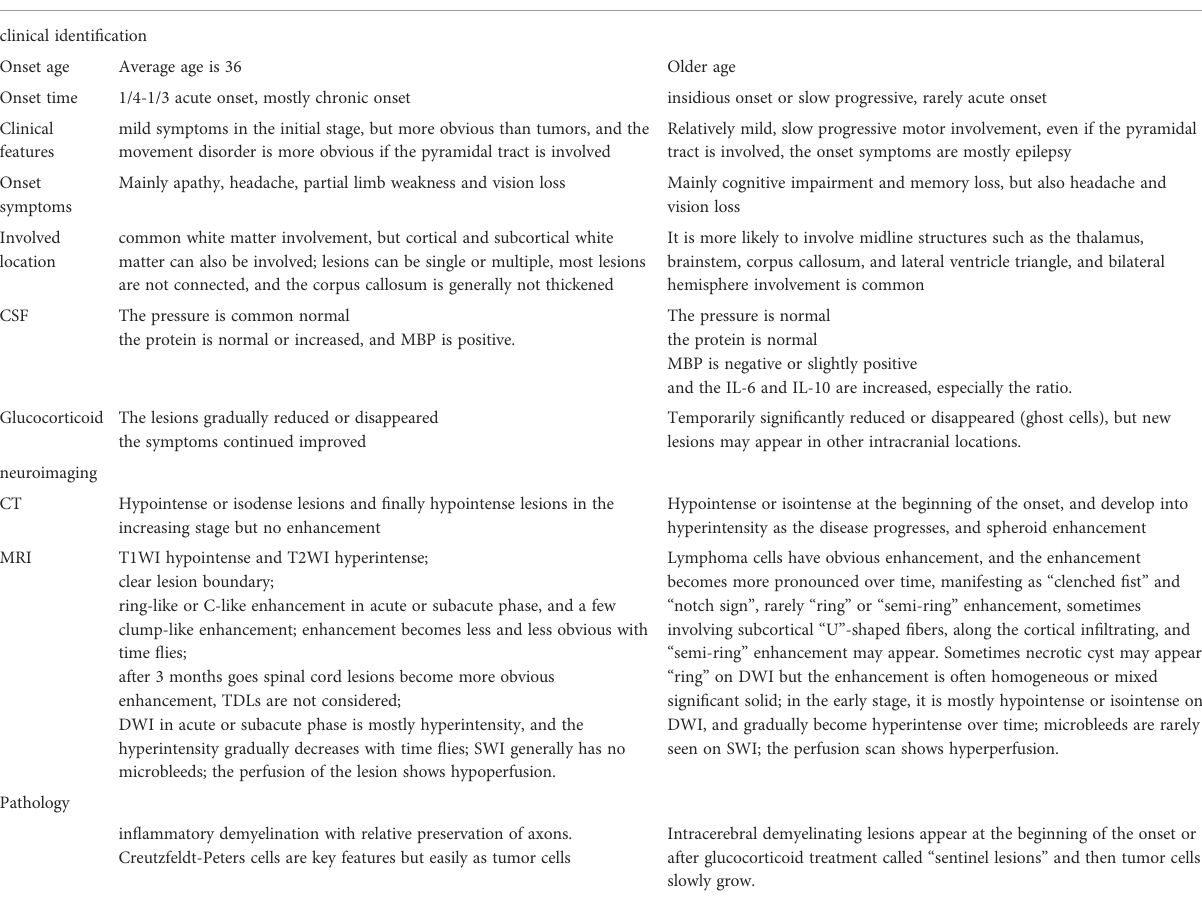
TABLE 1 The distinguishment between TDLs and PCNSL.